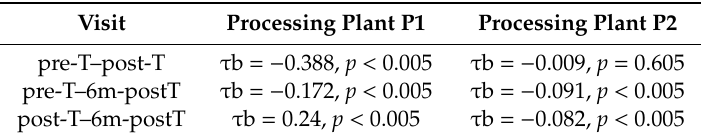
Table 3. Results of exact Kendall’s tau-b test of association between pre-stun shocks (PSS) and different visits.